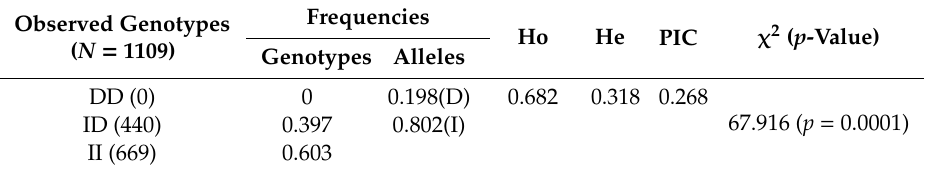
Table 2. Genetic parameters of the indel within Sox9 in Shaanbei white cashmere goat.